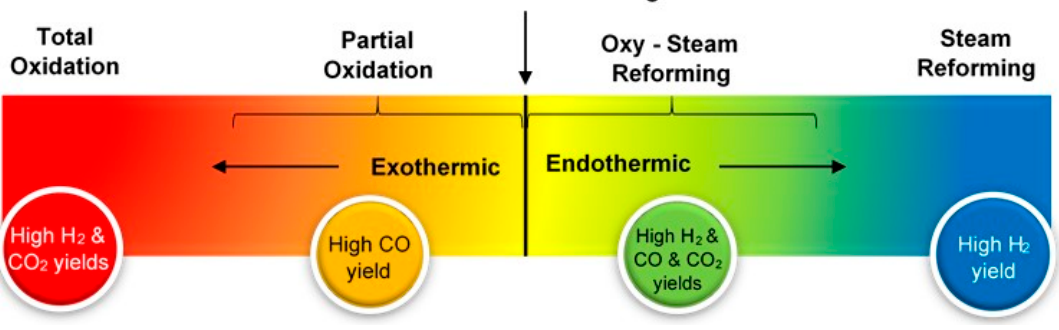
Figure 3. Illustration of a range of activities and conditions of methane processing [108,109].